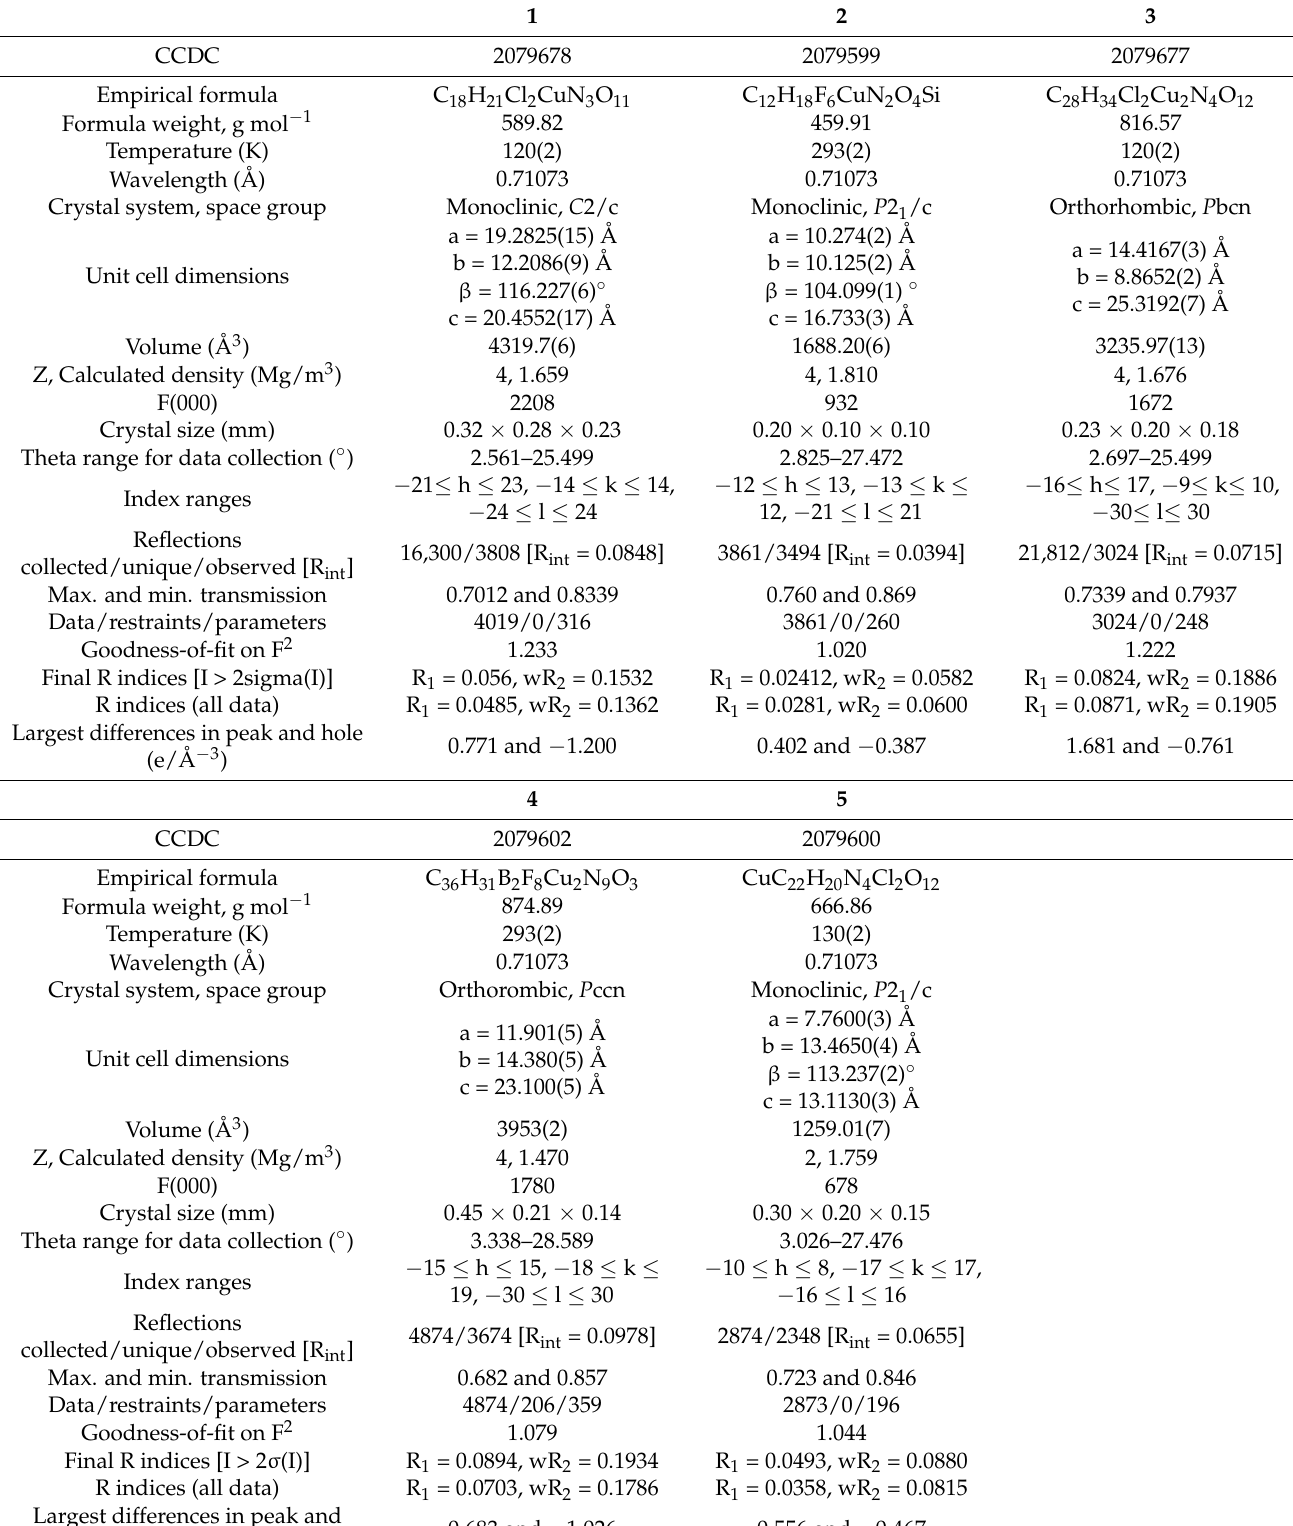
Table 1. Crystal data and structure refinement for compounds 1 – 5